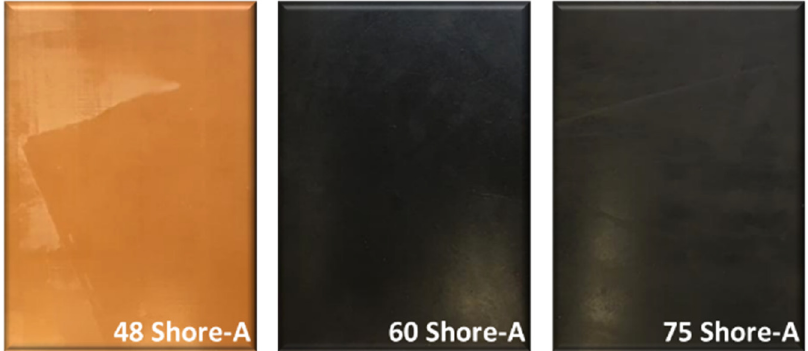
Figure 2. Images of the used rubber plates. Table 3. Rubber plates characterization results.